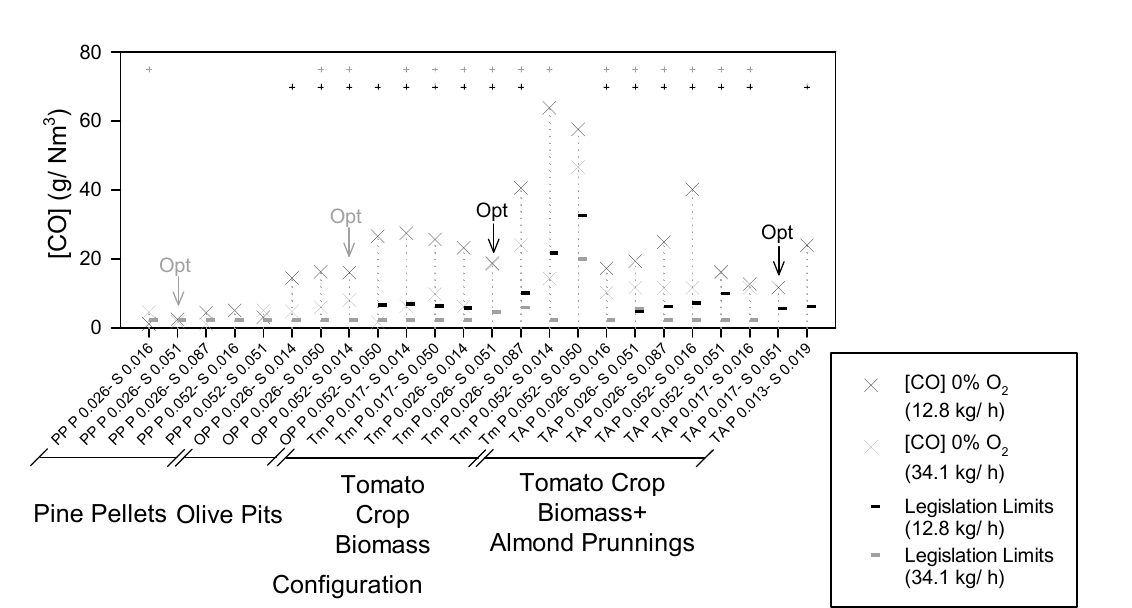
Figure 6. The thermal losses and heating efficiency recorded for each biomass type, their corresponding fuel inputs, and the primary and secondary air rates, together with the corresponding heating efficiency (Opt: Configuration identified as optimum; * Value surpassing 90%, theoretically).